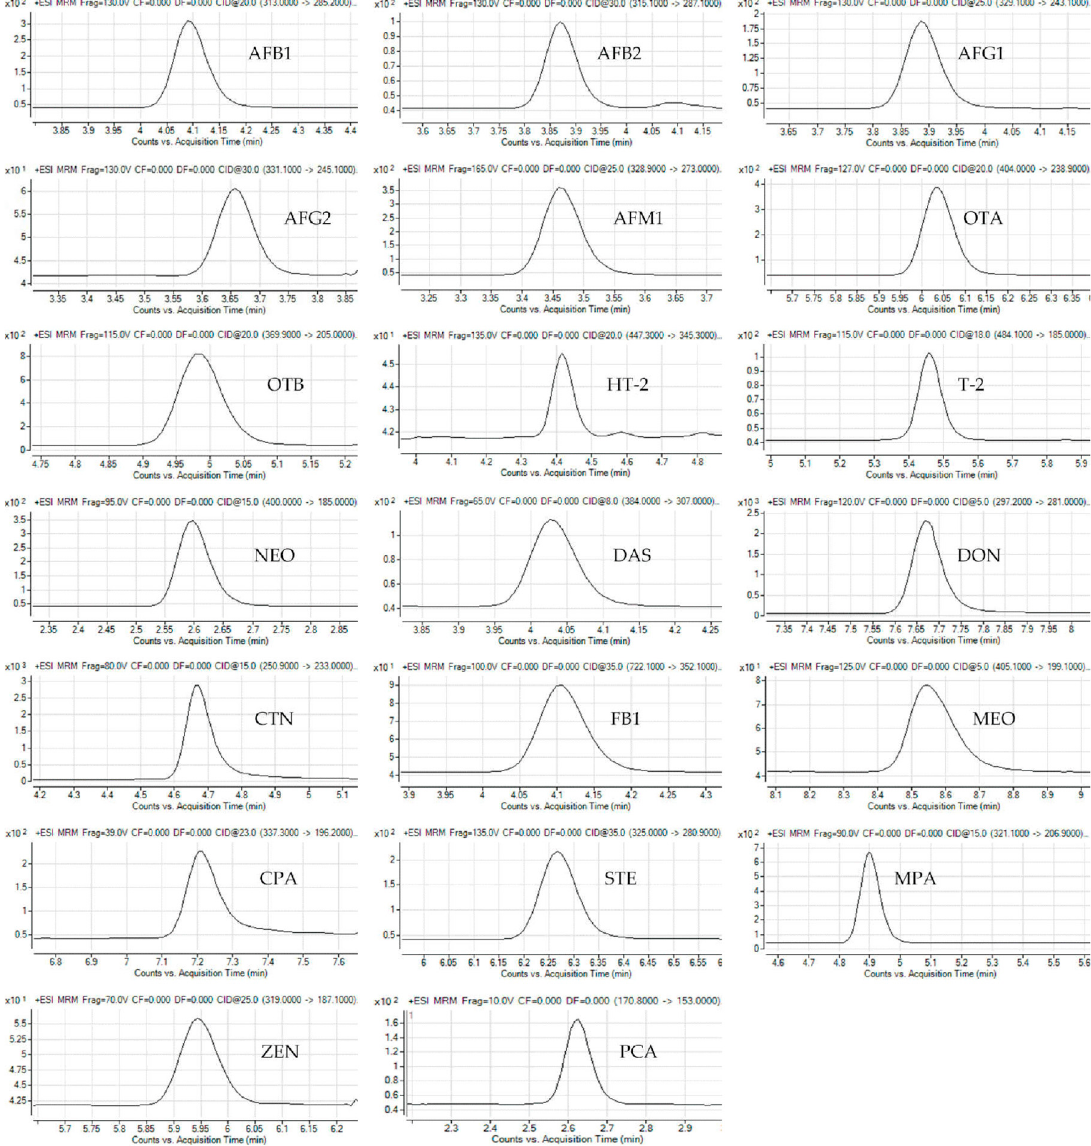
Figure 1. The extracted ion chromatograms of 20 mycotoxins in a standard solution under positive mode.